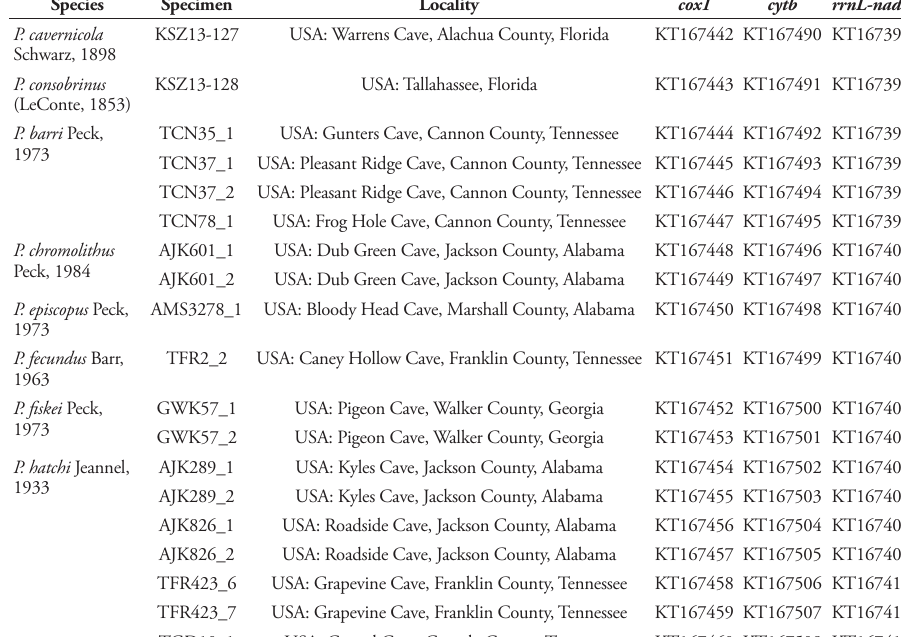
Table 1. Ptomaphagus specimens, sampling locations and Genbank accession numbers. Species